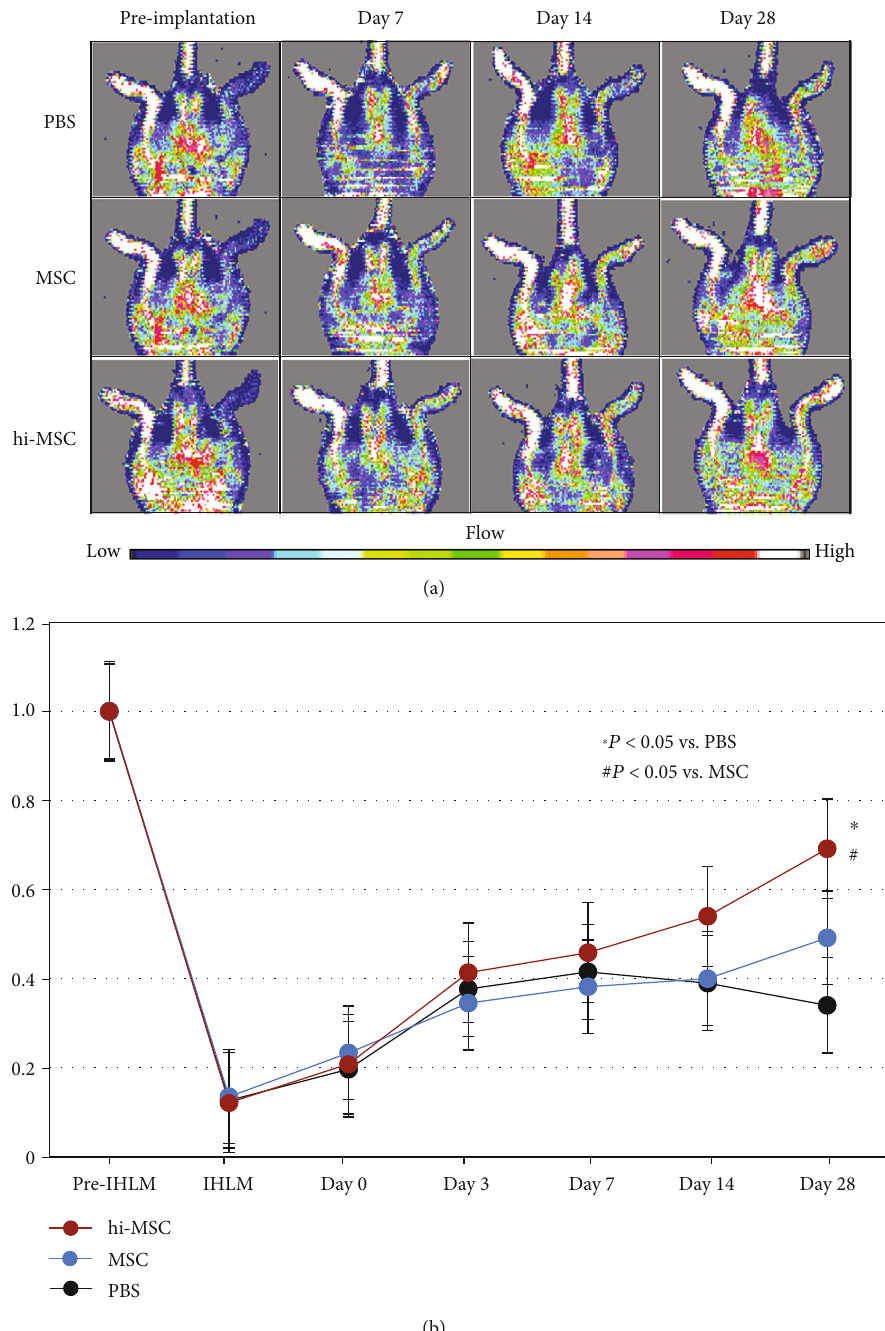
Figure 4: Serial laser Doppler perfusion images (LDPIs) before and after making the ischemic hindlimb model. (a) Representative images of LDPI studies. (b) LDPI index studies in phosphate-bu ff ered saline (PBS; n = 6 ), mesenchymal stem cell (MSC; n = 6 ), and hypoxia-induced MSC (hi-MSC; n = 6 ) implantation